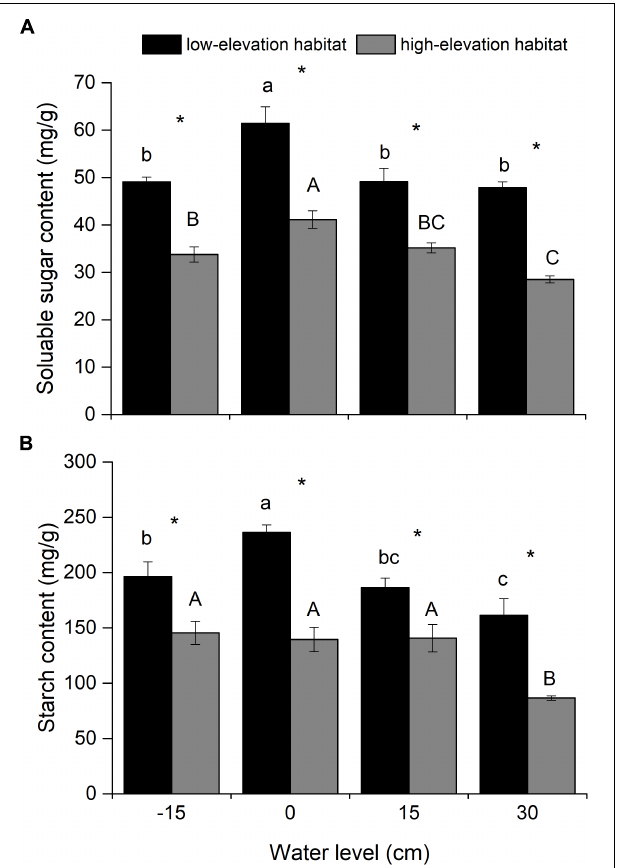
FIGURE 3 | Soluble sugar (A) and starch (B) contents in belowground biomass (roots and rhizomes) of P. hydropiper plants originating from two habitats grown under four water levels. Different lower-case or capital letters indicate that means differ significantly between the water level treatments for plants originating from low-elevation and high-elevation habitats, respectively. Symbols ( ∗ ) show which means differed between habitat types at each of the four water